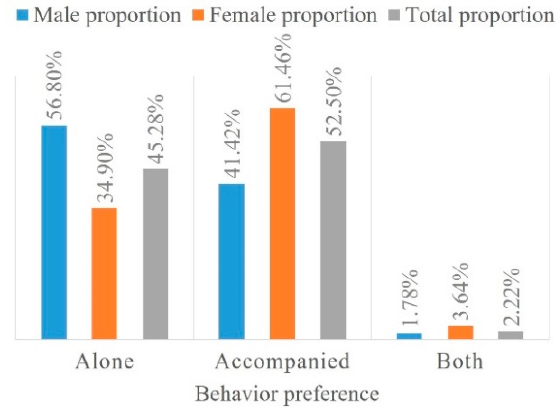
Figure 6. Being alone, accompanied or both.